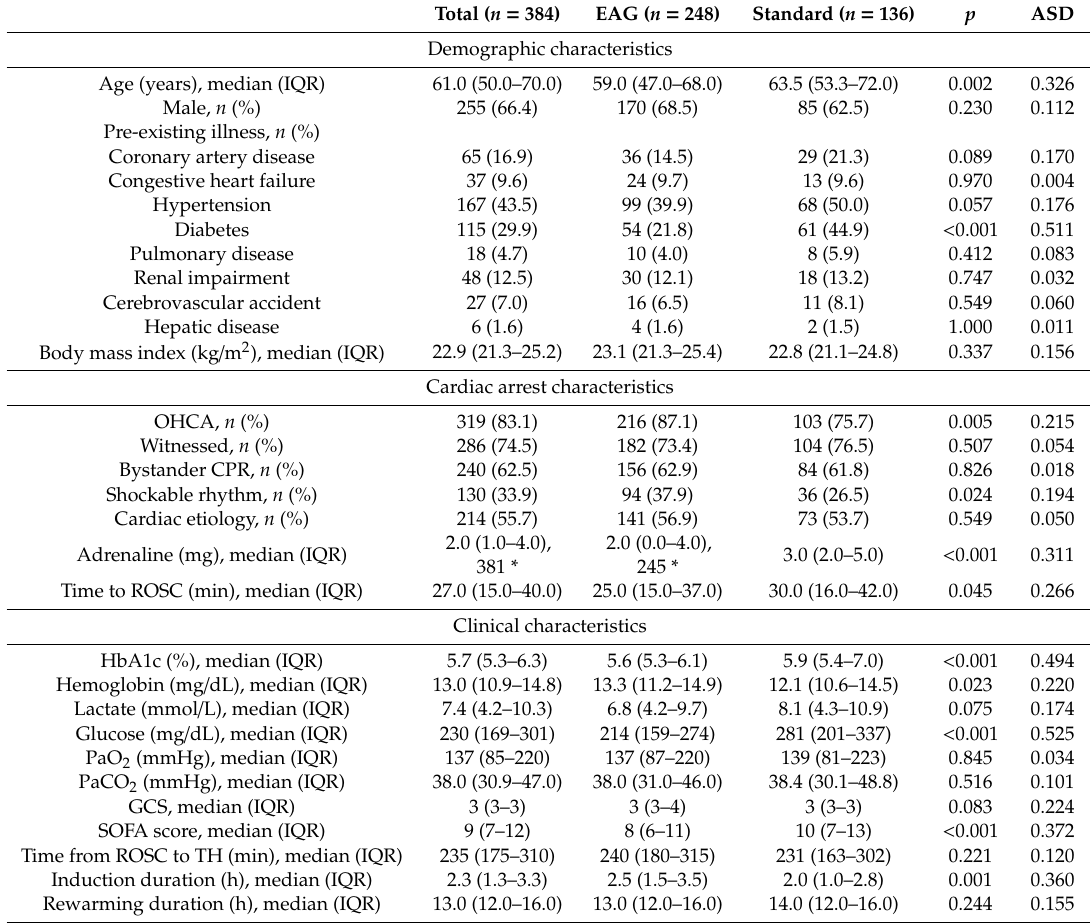
Figure 2. Serum glucose level during therapeutic hypothermia according to estimated average glucose or standard glucose groups. I, induction phase; M, maintenance phase; R, rewarming phase. *, Number of patients included in the analysis. Table 2. Demographic, cardiac arrest, and clinical characteristics between EAG and standard groups.